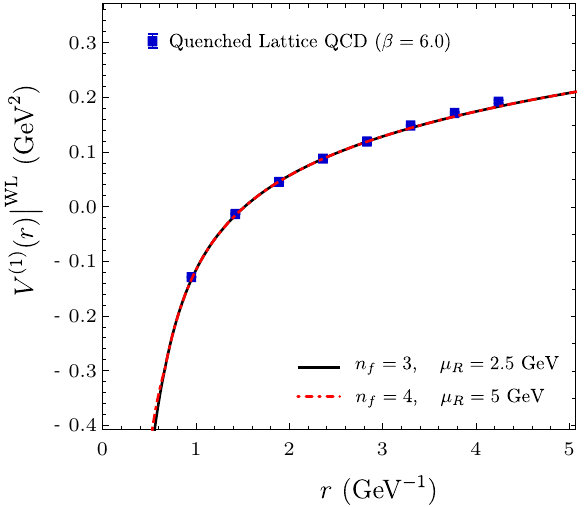
) 1 / 2 at LO (black R